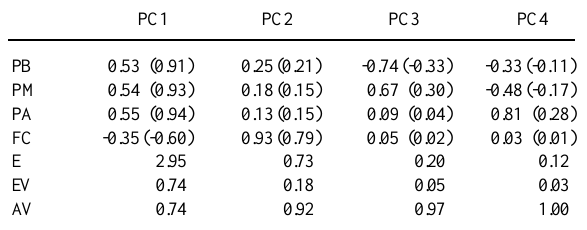
Correlation coefficient between the PC and each variable in parentheses. For abbreviations see legend to Table